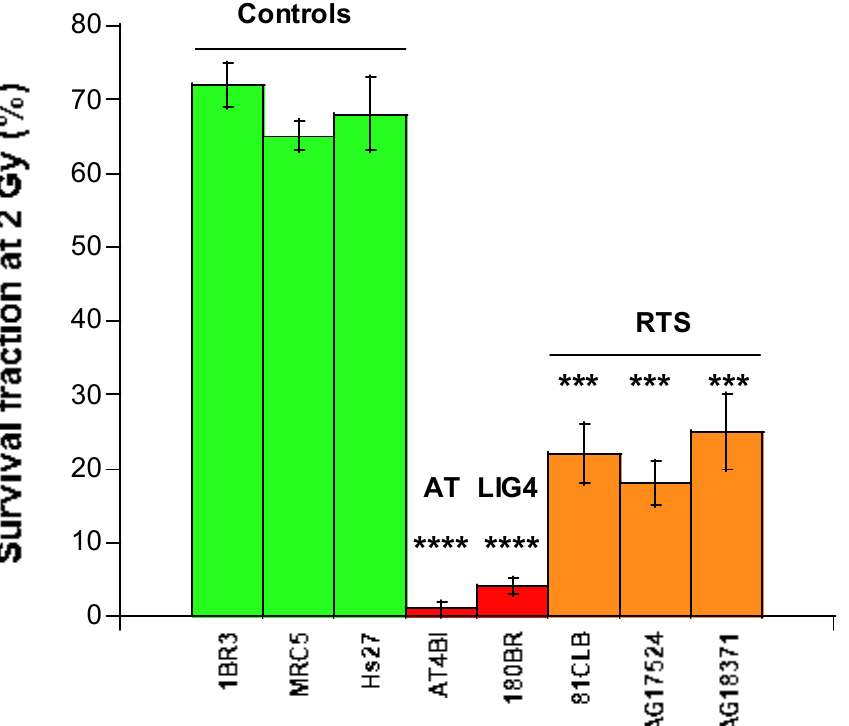
Figure 1. Clonogenic cell survival in RTS fibroblasts. Clonogenic cell survival assay was applied at 2 Gy to the radioresistant controls (1BR3, MRC5, Hs27), the hyper-radiosensitive ATM - (AT4BI) and LIG4 - (180BR) mutated and the three RTS (81CLB, AG17524, AG18371) fibroblast cell lines. Each plot represents the mean ± SEM of at least two replicates. Asterisks represent statistical differences with radioresistant controls expressed as the p -value (3 and 4 asterisks correspond to p < 0.001 and p < 0.0001, respectively). AT: ataxia telangiectasia; LIG4: LIG4 syndrome. 3.2. Abnormally High Levels of Micronuclei in RTS Fibroblasts The propagation of unrepaired DNA breaks up to mitosis may lead to irreversibly damaged chromosomal fragments causing mitotic death. Some chromosomal fragments may escape from the metaphases and generate micronuclei. Micronuclei have been shown to be quantitatively correlated with cellular radiosensitivity [25]. No significant difference was found between the spontaneous micronuclei in RTS cells and those in radioresistant controls ( p > 0.5). Conversely, the number of spontaneous micronuclei per 100 cells was significantly higher in the two hyper-radiosensitive fibroblasts ( p < 0.02). After 24 h post- irradiation, the number of residual micronuclei per 100 cells was significantly higher in the RTS fibroblasts ( p < 0.001) compared with the radioresistant controls but lower than that observed in the hyper-radiosensitive fibroblasts ( p < 0.0001) (Figure 2A), supporting a significant genomic instability in the RTS fibroblasts tested (Figure 2A). The average number of residual micronuclei per 100 cells was 13.3 ± 2.0 in the RTS fibroblasts while it was 55 ± 10 and 1.1 ± 0.5 in the hyper-radiosensitive and radioresistant control fibroblasts, respectively. The survival and micronuclei data from the three fibroblast cell lines were in full agreement with the correlation established between SF2 and micronuclei with fibro- blasts from different genetic diseases and published recently [45] (Figure 2B).